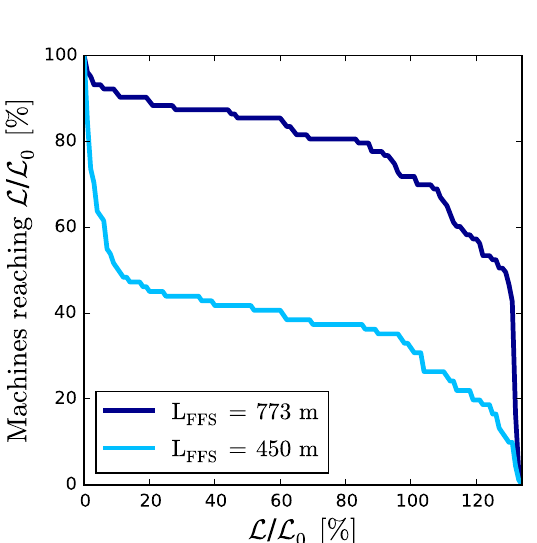
FIG. 24. Tuning efficiency after one iteration of BBA and three iterations of linear knobs for L L ¼ 770 m with L (cid:1) ¼ 3 . 5 m. FFS